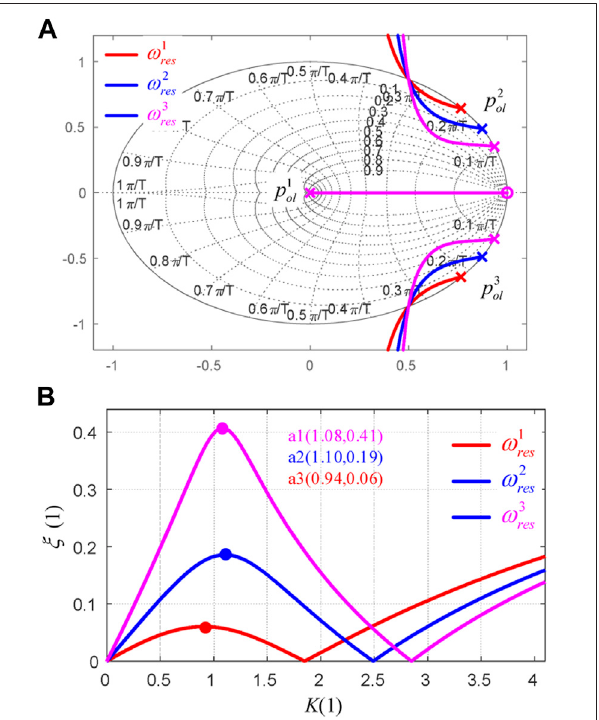
FIGURE 8 | Root locus and active damping of the plant when K varies, where (A) shows the root locus and (B) shows the plot of K vs ξ